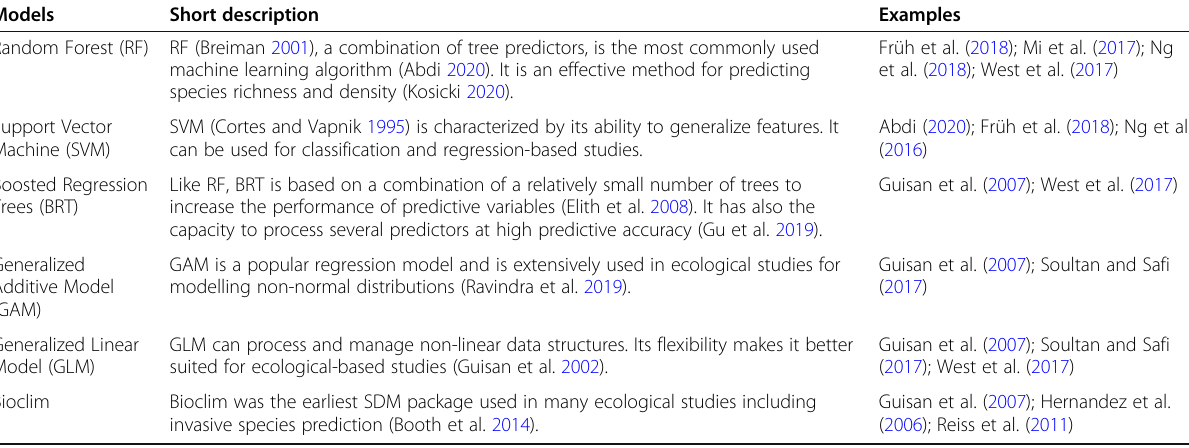
Table 2 Predictive models from machine learning (RF, SVM, and BRT), regression (GAM and GLM), and profile (bioclim) methods and their short description and common pieces of literature that have used these models in modelling invasive species distribution